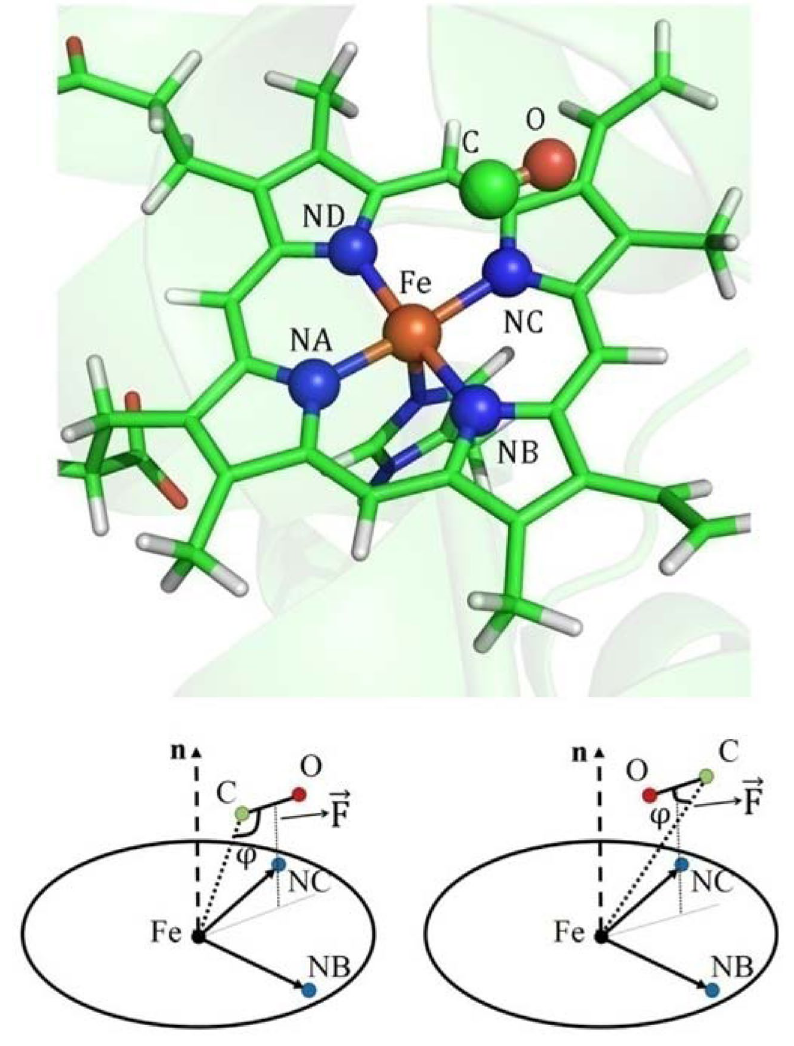
Figure 1. The location of the CO in the docking site of the myoglobin for the B state (upper). The structure was extracted from the QM/MM MD simulation. Graphical representations of the B 1 state (lower left panel) and B 2 state (lower right panel). Here, ϕ is the angle that is defined as Fe  C ≡ O. The heme is depicted as a circular → plate, and n is the normal vector of the plate plane, and F represents the electric field exerted by the